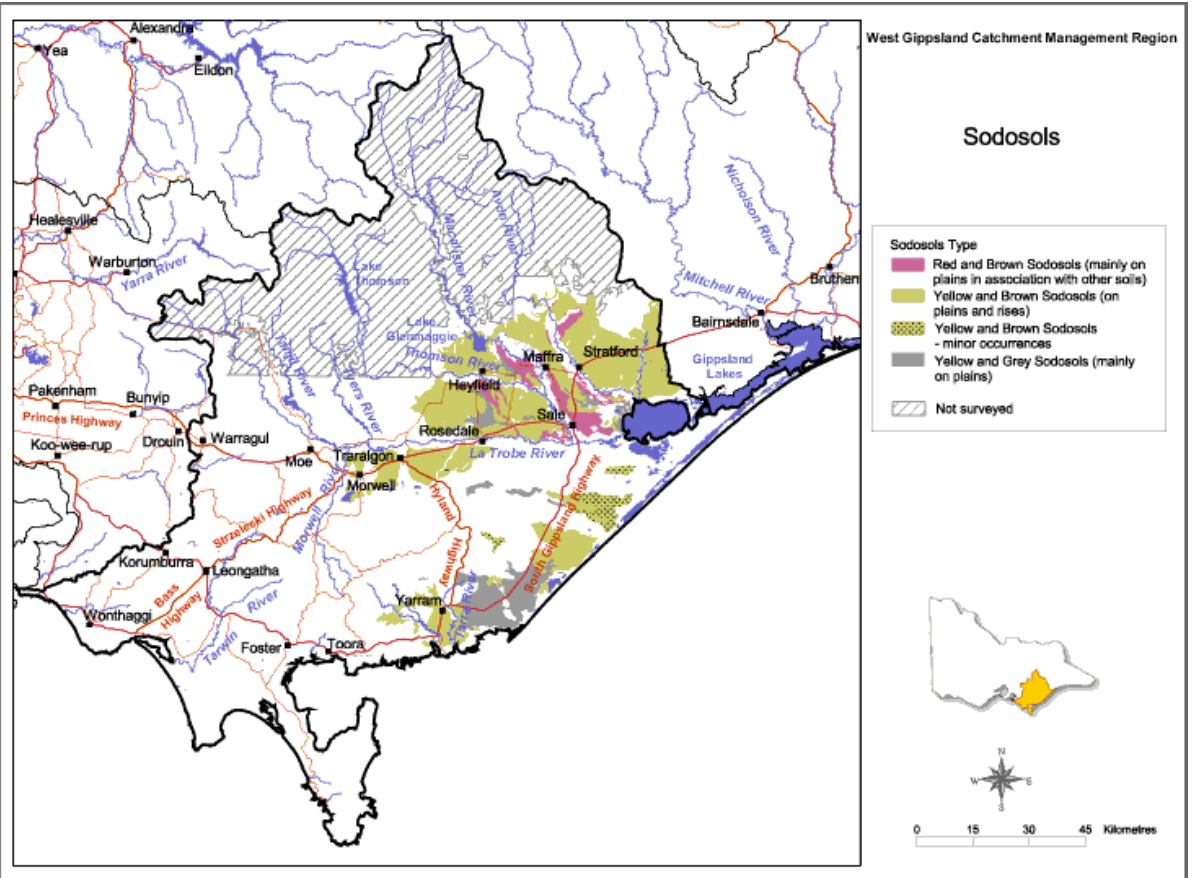
Figure 12. Overview soil map for the “Sodosol” Soil Order in the West Gippsland region.  State of Victoria, Department of Primary Industries 1997 Reproduced with